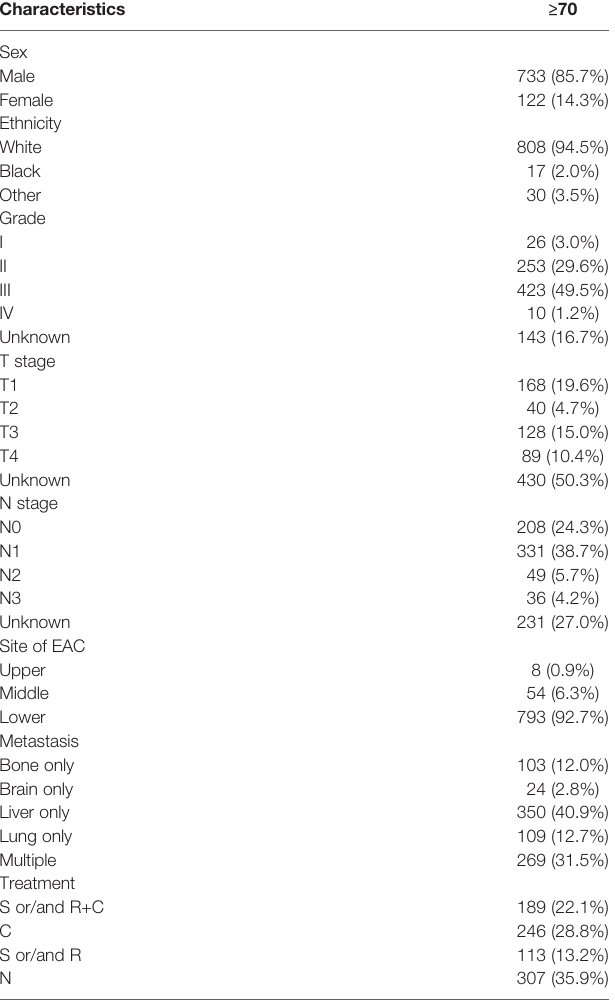
TABLE 1 | Characteristics of elderly EAC patients with DM.